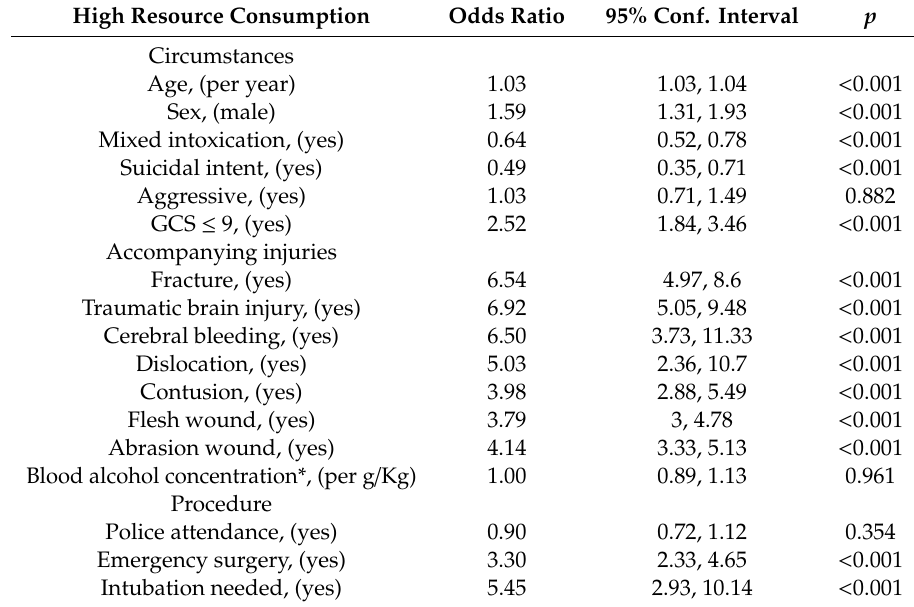
Table 3. Univariate association between clinical characteristics and high resource consumption. High Resource Consumption Odds Ratio 95% Conf. Interval